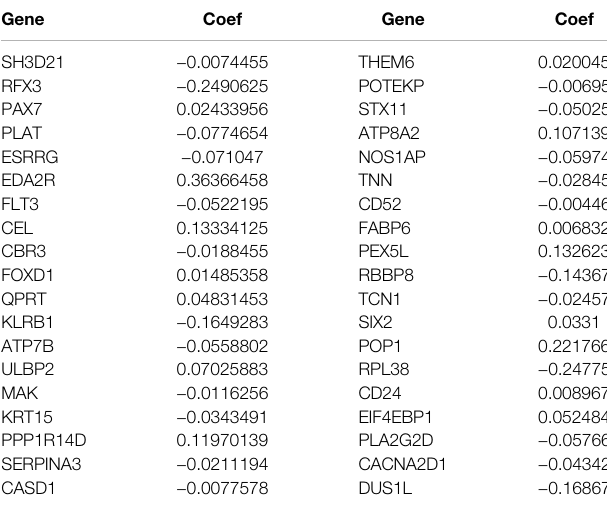
TABLE 2 | All coef fi cients of the genes in the